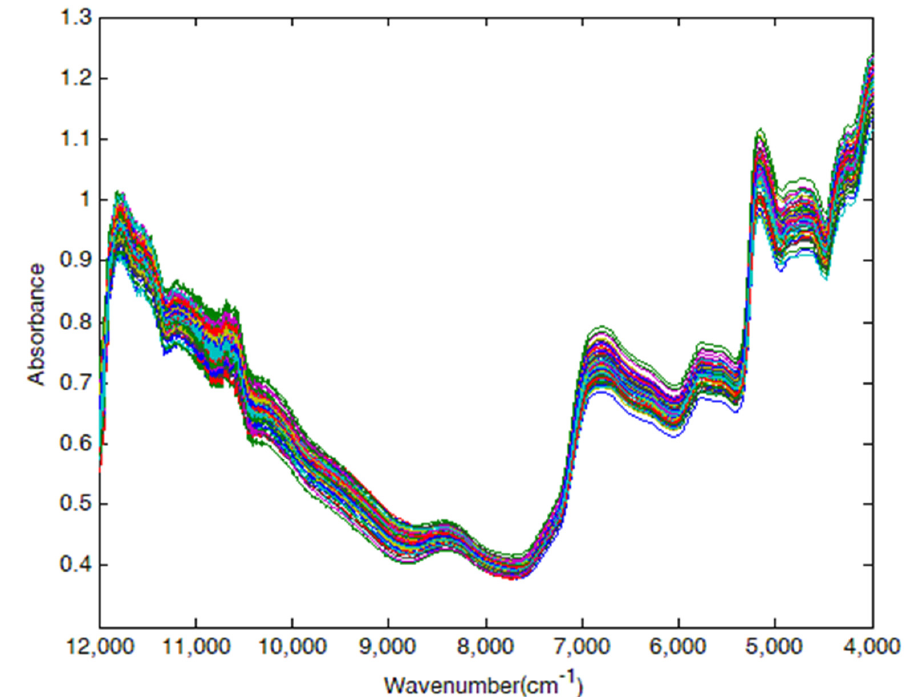
Figure 1. Raw NIR spectra of Sargassum horneri samples.